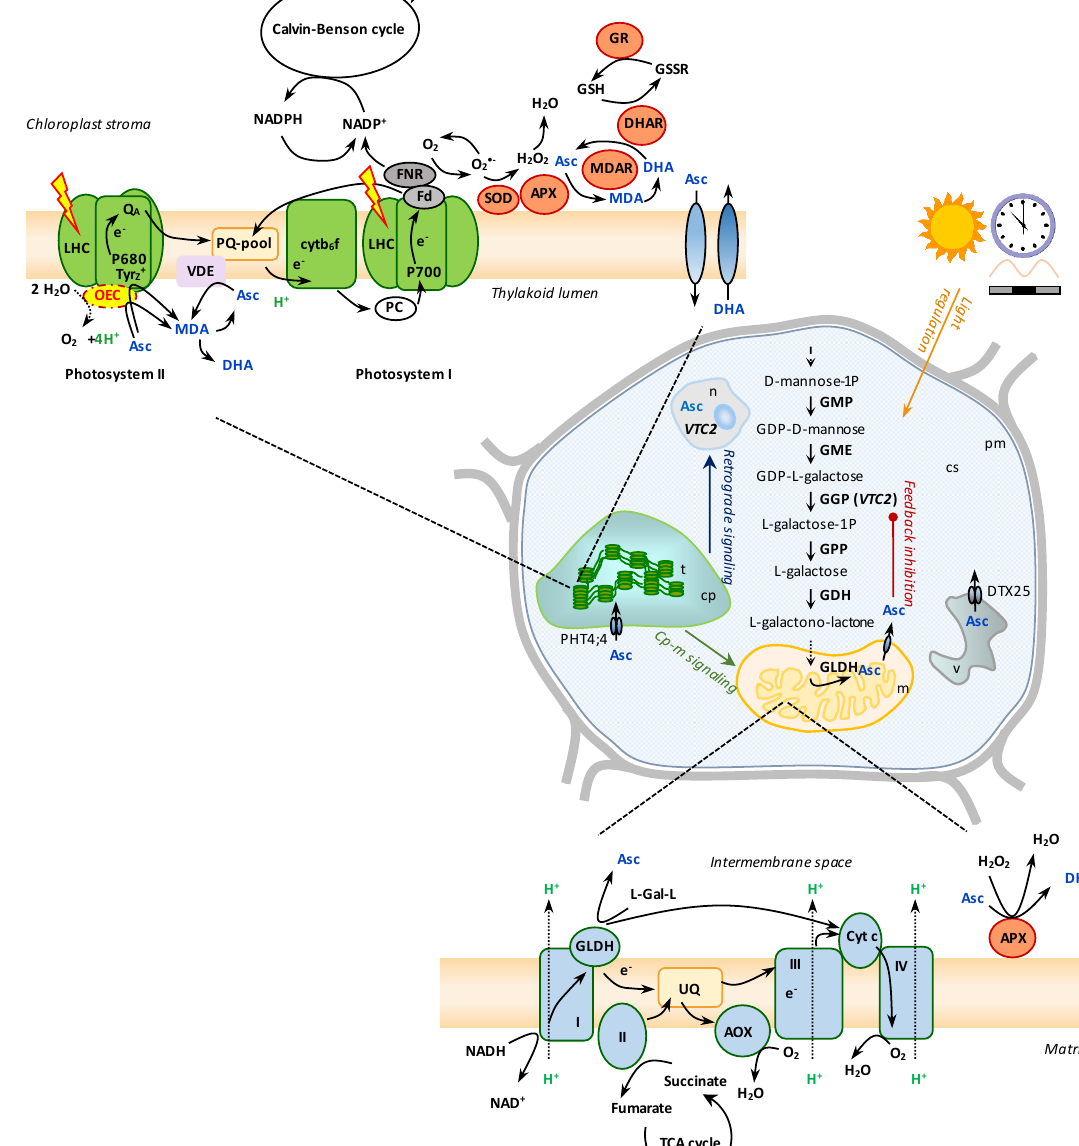
Asc. The MDA radicals are then recycled back to Asc through MDA reductases (MDARs)